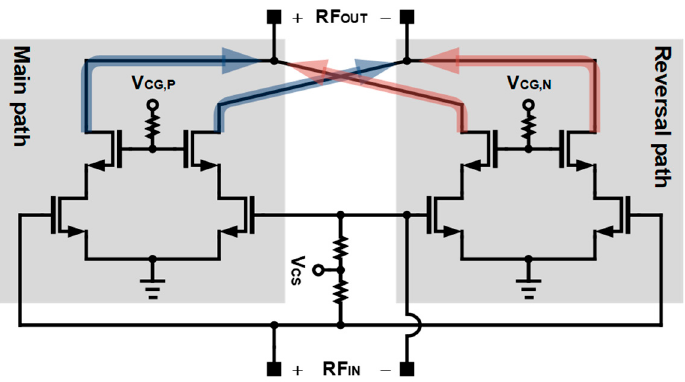
Figure 3. Schematic of the typical structure with 180° phase-shift function.